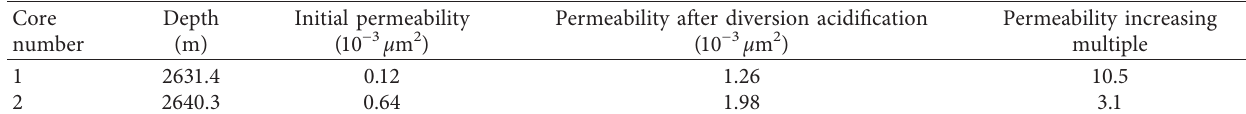
Figure 3: The curve of pressure of change of the core of the H2 well. Table 3: Experimental results of H2 core diversion acidification.